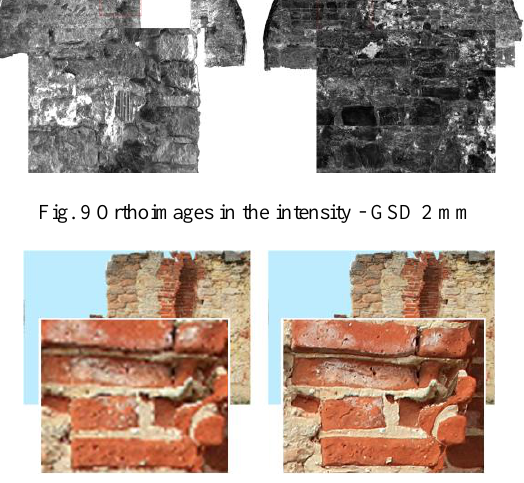
Fig. 10 Fragments of RGB orthoimages a) from a